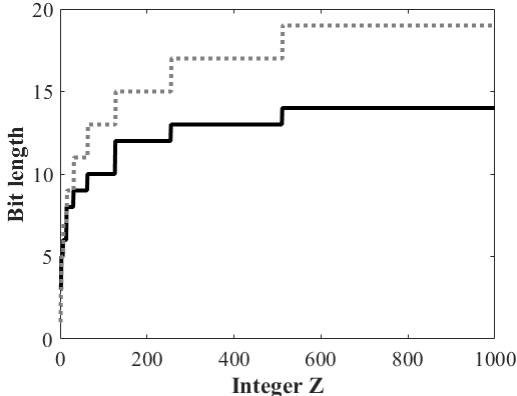
Figure 1. Comparison of bit lengths of encoded integers Z from 1 to 1000 by using the proposed and exponential Golomb code methods.